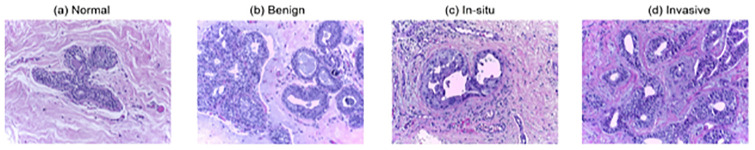
Examples of ICIAR2018 pathology images [32].Images from left to right correspond to normal breast tissue, benign tumor, in-situ breast carcinoma, and invasive breast cancer, respectively.